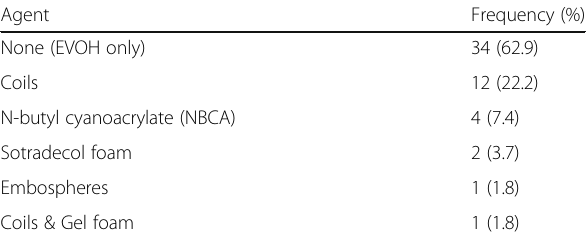
Table 3 Adjunctive embolic agents that were used with EVOH Agent